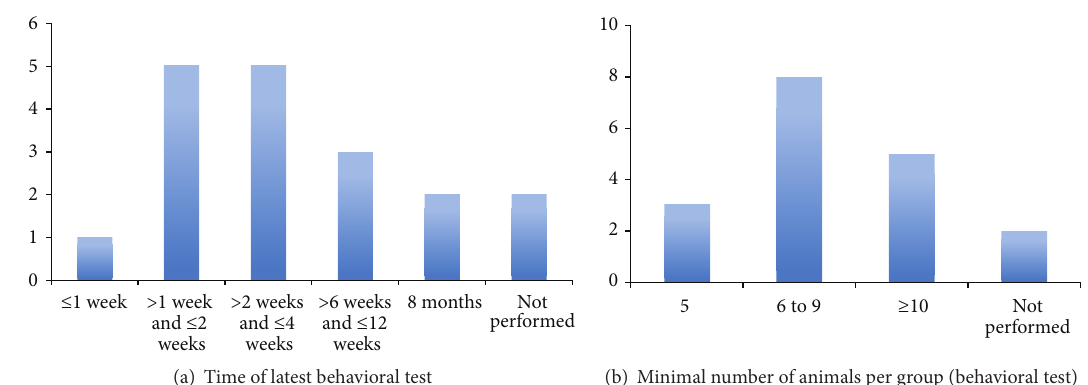
Figure 3: Charts summarizing the timing of the latest behavioral test (a) and the minimal number of animals per experimental group (b) in preclinical studies that have evaluated the therapeutic potential of bone marrow-derived cells for hemorrhagic